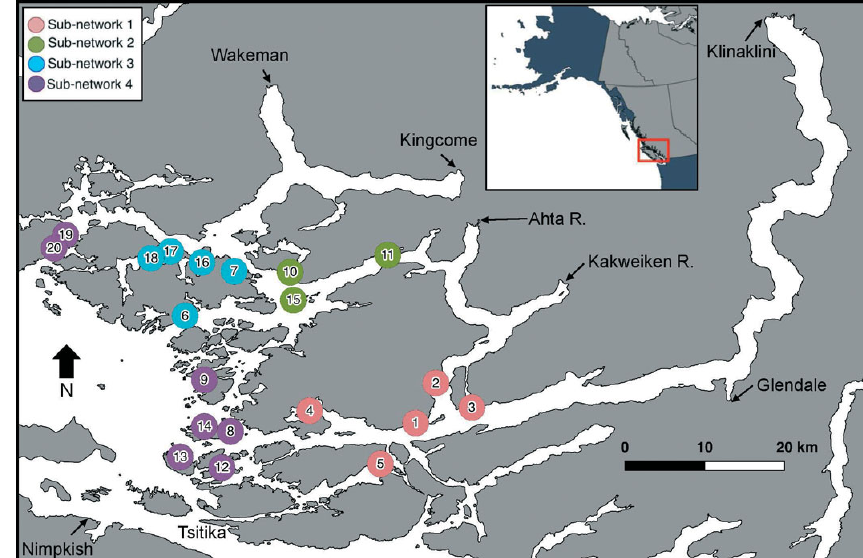
Fig. 1. The Broughton Archipel- ago and salmon farm locations used in the simulation. Sub-net- works of farms (identified from Cantrell et al. 2018, 2020a) have been given matching colours. Sub-network 1 includes Farms 1–5; Sub-network 2 includes Farms 10, 11, and 15; Sub-net- work 3 includes Farms 6, 7, 16, 17, and 18. Sub-network 4 repre- sents a group of farms which ex- hibited low connectivity in the bio-physical simulation, and in- cludes Farms 8, 9, 12, 13, 14, 19 and